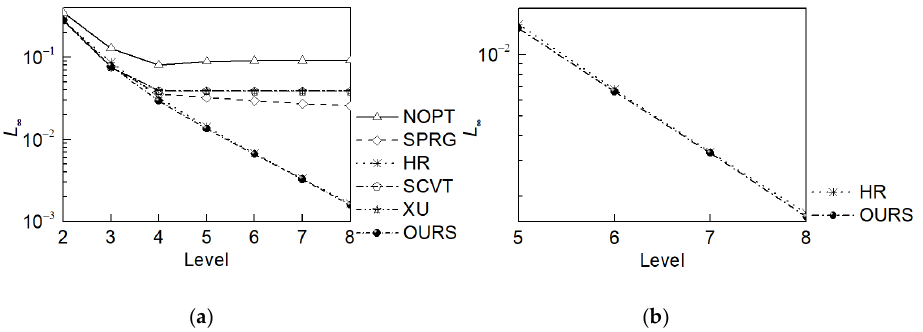
Figure 14. L ∞ -norm error of Laplacian operator. ( a ) L ∞ -norm error of all grids ( b ) L ∞ -norm error of OURS and HR grid from level 5 to 8 The L 2 ‐ norm errors and L ∞ ‐ norm errors of all grids have been reduced as resolution increase, ones of OURS grid and HR grid are smaller than the others. The L ∞ ‐ norm error (meaning the maximal error) of OURS grid has been reduced from 9.15 × 10 − 2 (NOPT grid), 2.57 × 10 − 2 (SPRG grid), 1.66 × 10 − 2 (HR grid), 3.87 × 10 − 2 (SCVT and XU grid) to 1.59 × 10 − 2 at level 8. The L 2 ‐ norm error (meaning the RMS error) of OURS grid has been reduced